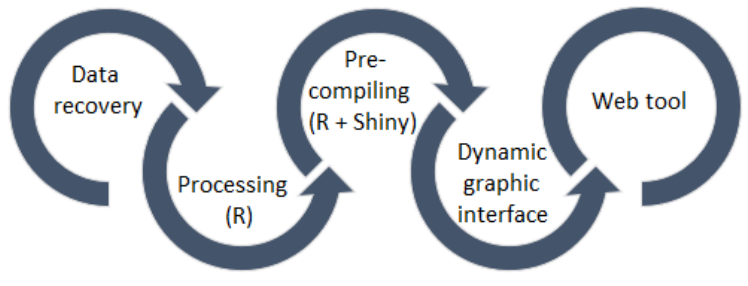
Figure 1. Flowchart of the methodology